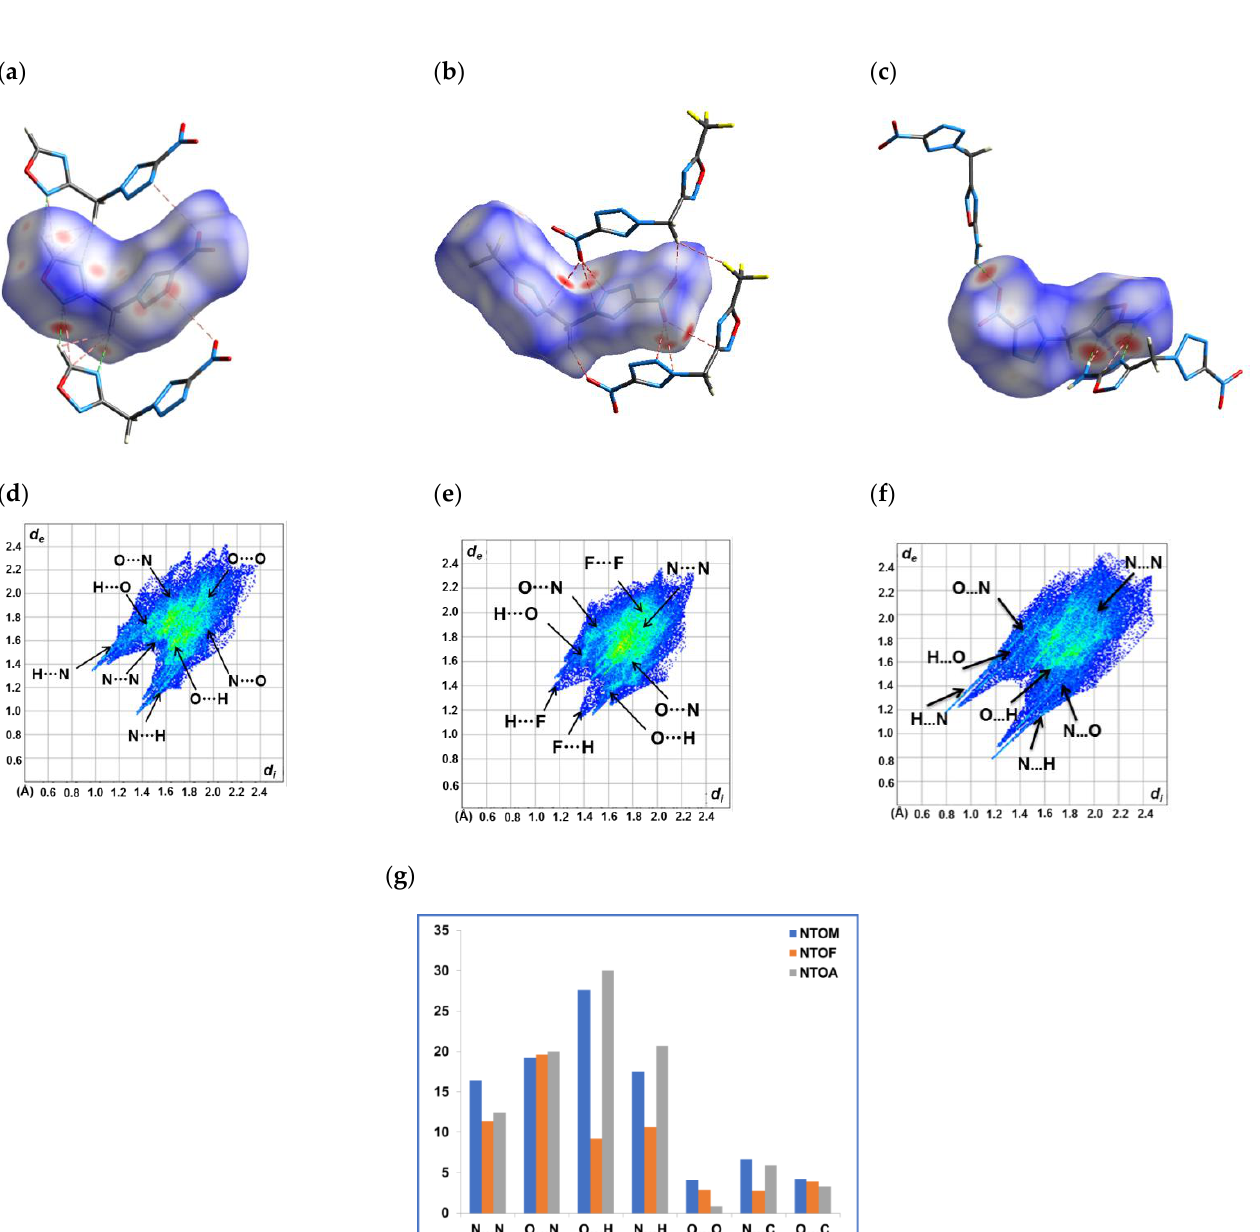
Figure 7. Hirshfeld surface of NTOM ( a ); Hirshfeld surface of NTOF ( b ); 2D fingerprint plot of NTOA ( c ); 2D fingerprint plot of NTOM ( d ); 2D fingerprint plot of NTOF ( e ); 2D fingerprint plot of NTOA ( f ); comparison of the amounts of close interactions in NTOM, NTOF and NTOA ( g ).